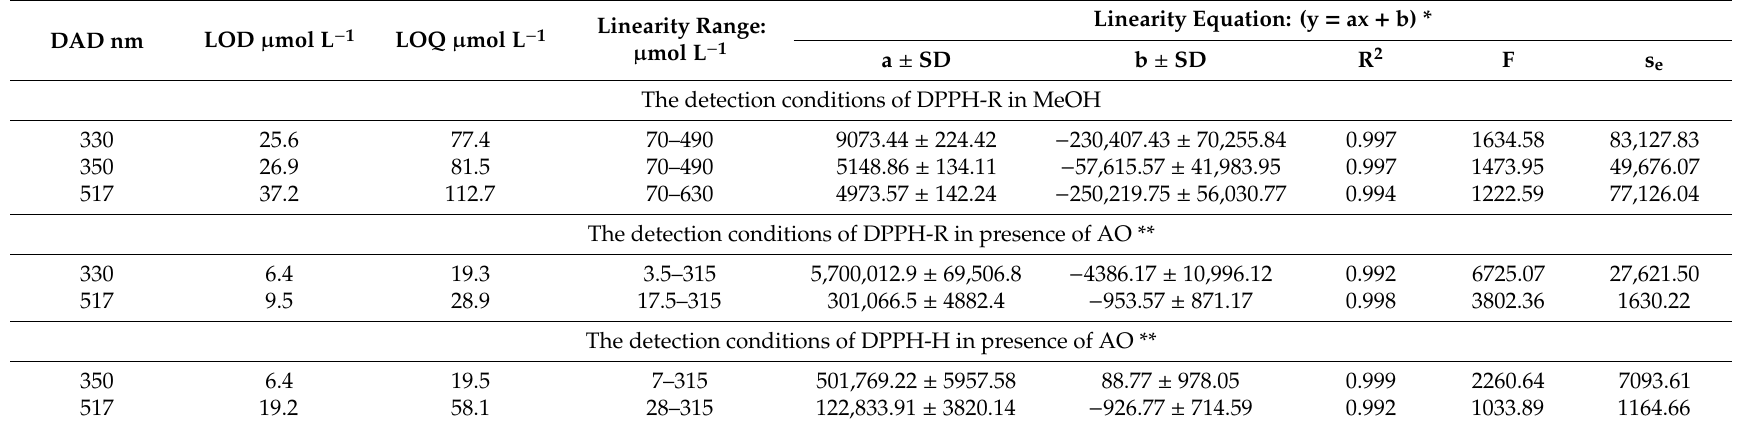
Table 1. Linearity range, limits of quantification (LOQ) and detection (LOD) parameters for the detection conditions of DPPH-R /